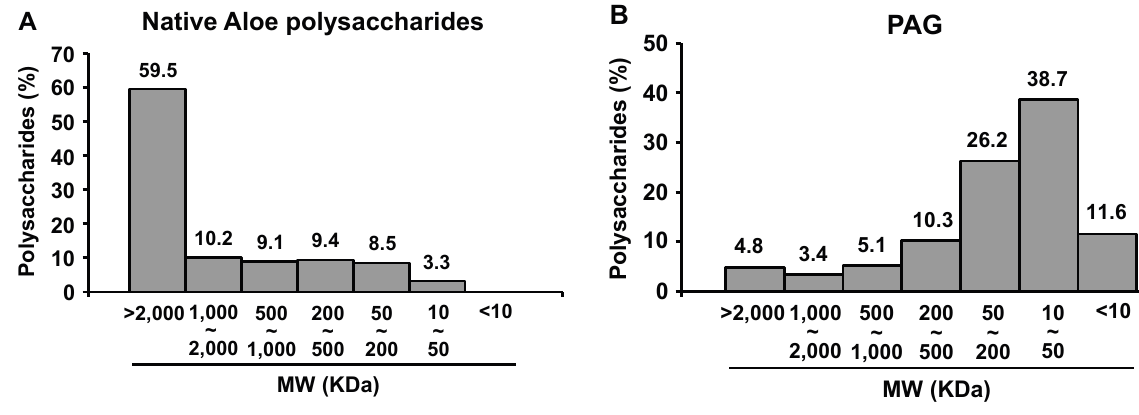
Figure 1. Comparison of the molecular sizes of the polysaccharides in native Aloe vera gel ( A ) and in PAG ( B